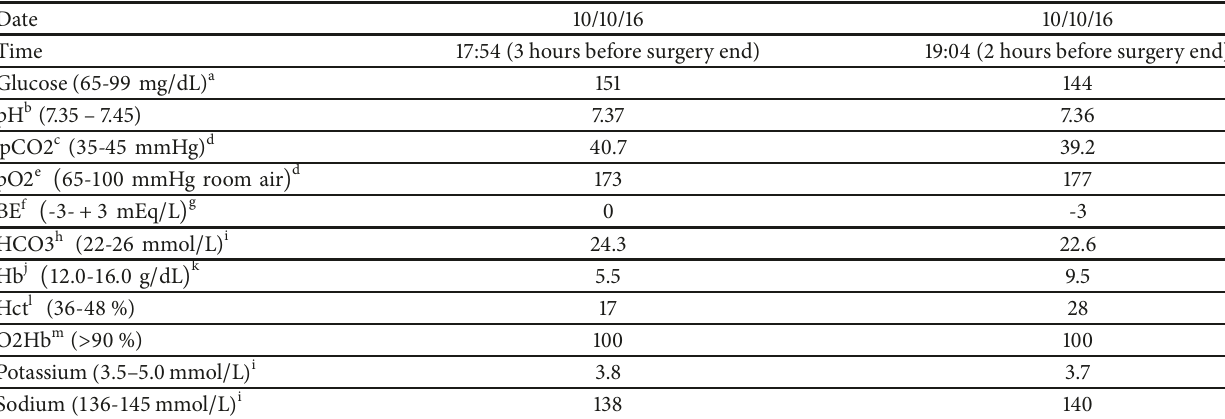
Table 1: Arterial-blood gases at 3 and 2 hours before end of surgery.